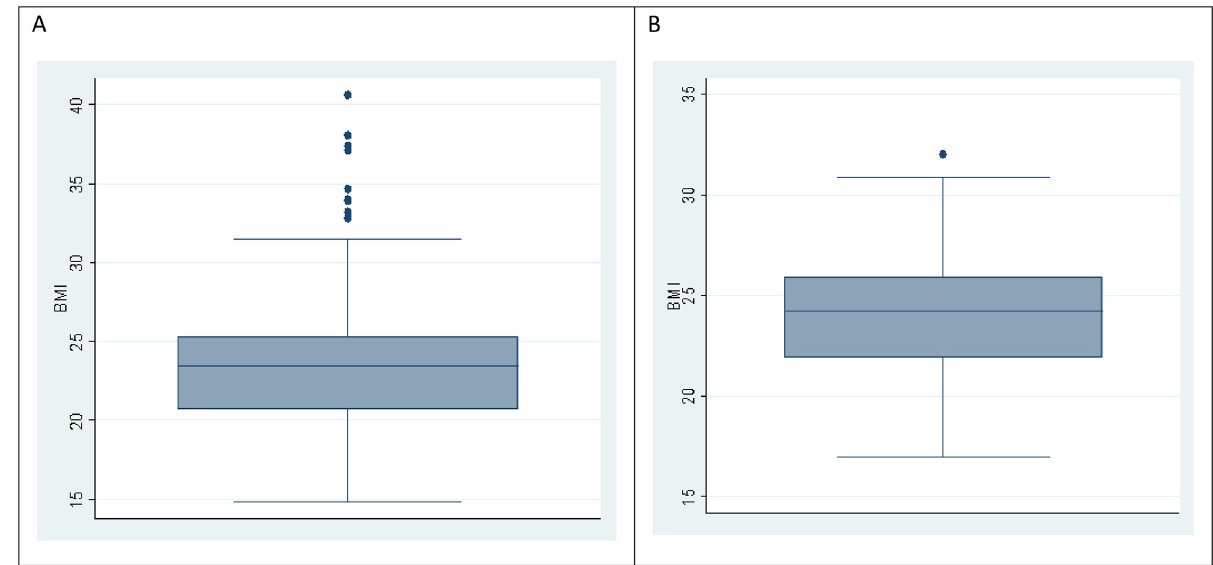
Fig 2. Distribution boxplots of BMI for participants with positive QFTPlus (A) and negative QFTPlus (B) results.